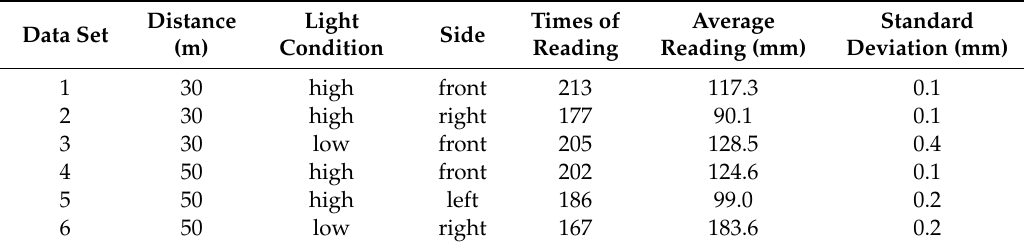
Table 5. Height reading stability analysis when the camera lens is static.